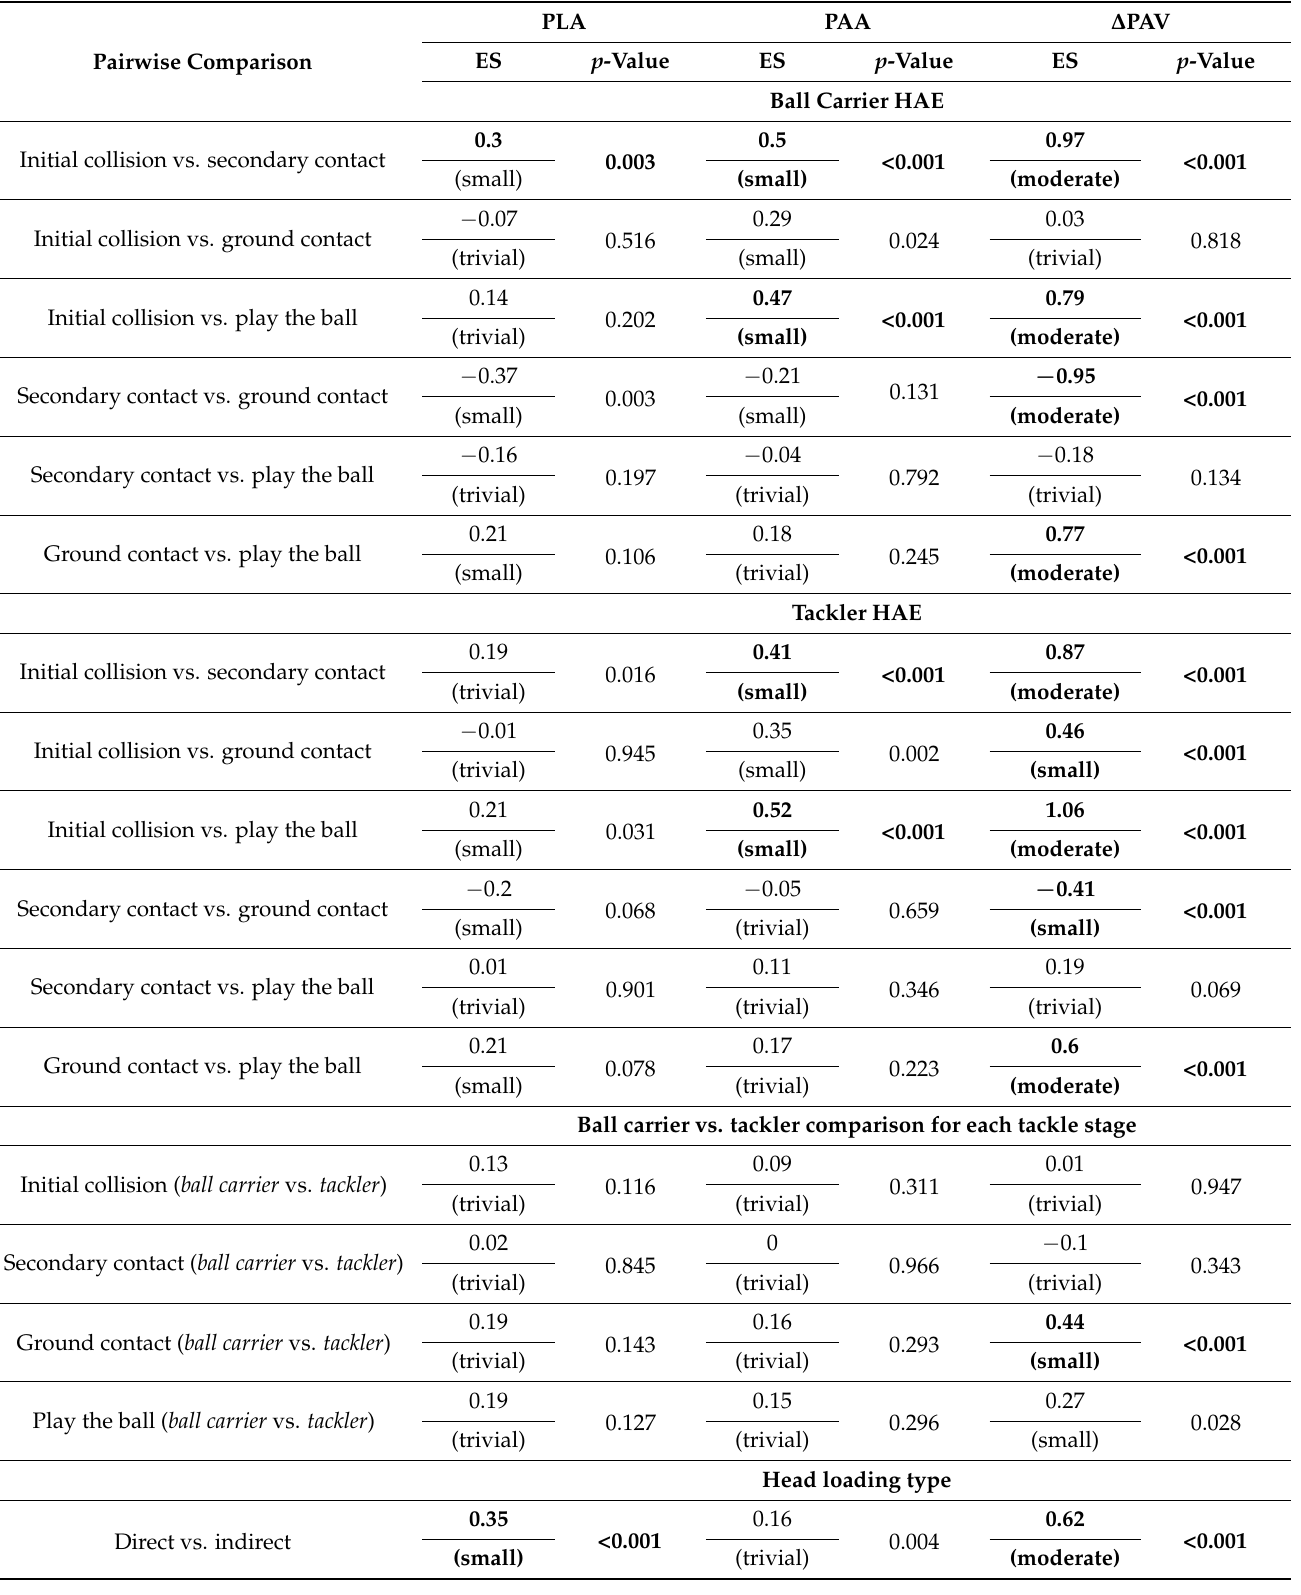
Table 2. Pairwise comparisons from mixed-effects linear models 1 and 2. Following a Bonferroni correction, the alpha value was set at 0.001. Significant comparisons are